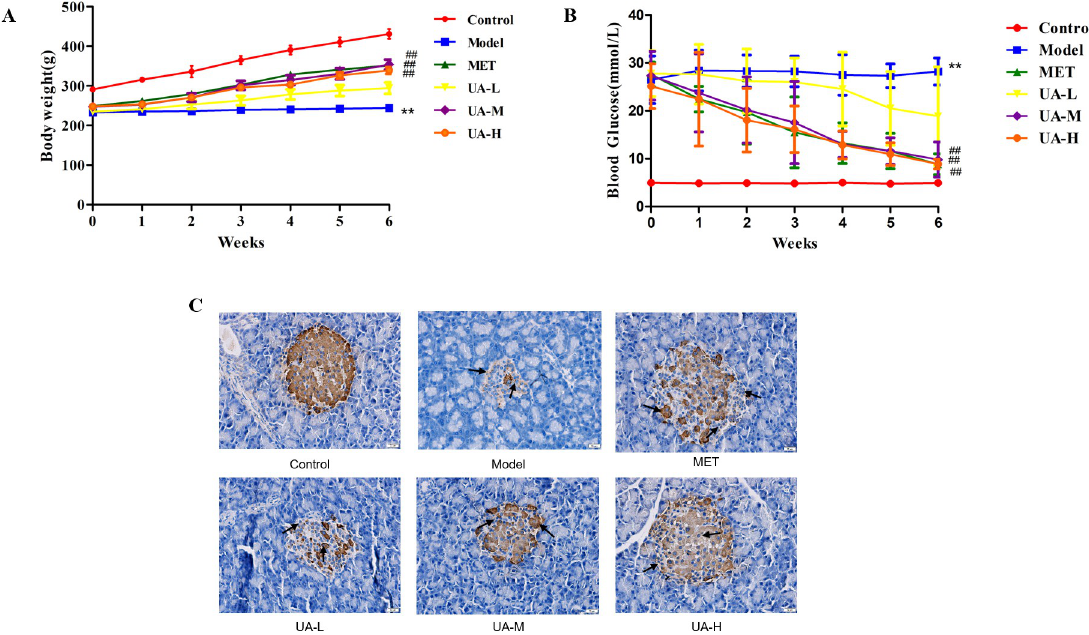
Fig 1. UA treatment alleviated pancreatic β cells injury and reduced FBG level in T1DM rats. Rats were divided into six groups: blank controls (Control), T1DM rats (Model), T1DM rats treated with metformin (MET), T1DM rats treated with low-dose [25 mg/kg (bw)/ day] UA(UA-L), middle-dose [50 mg/kg (bw)/day] UA(UA-M) and high-dose [100 mg/kg (bw)/day] UA(UA-H). (A) Body weight change: Each group of rats was weighed weekly during the observation period (n = 10–12). (B) Fasting blood glucose levels (n = 10–12). (C) Histological changes in pancreatic islets and insulin secretion (shown by black arrows) were detected by IHC staining(original magnification × 400; scale bar, 200 μ m). Data are expressed as mean ± SD. �� P < 0.01 versus the control, � P < 0.05 versus the control; ## P < 0.01 versus Model, # P < 0.05 versus